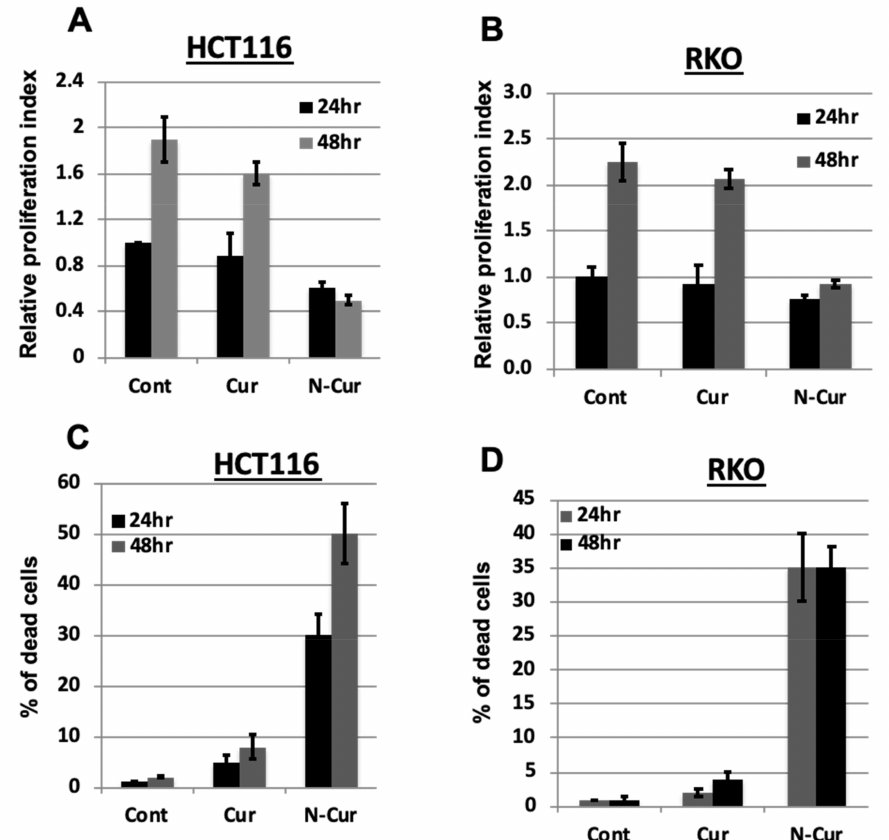
Figure 2. Effect of NO–curcumin on colon cancer cell proliferation and cell death. ( A , B ) Represen- tative statistical analysis of the effect of curcumin (cur) and nitro-curcumin (N-cur) on HCT116 ( A ) and RKO ( B ) cell proliferation as measured by XTT assay after treating the cells with 40 µ M of both compounds for the indicated time points; untreated cells were used as control and day zero, the day of treatment, was used as a reference point. ( C , D ) Representative statistical analysis of the effect of curcumin (cur) and nitro-curcumin (N-cur) on HCT ( A ) and RKO ( B ) cell death as measured by trypan blue exclusion assay after treating the cells with 40 µ M of both compounds for the indicated time points; untreated cells were used as